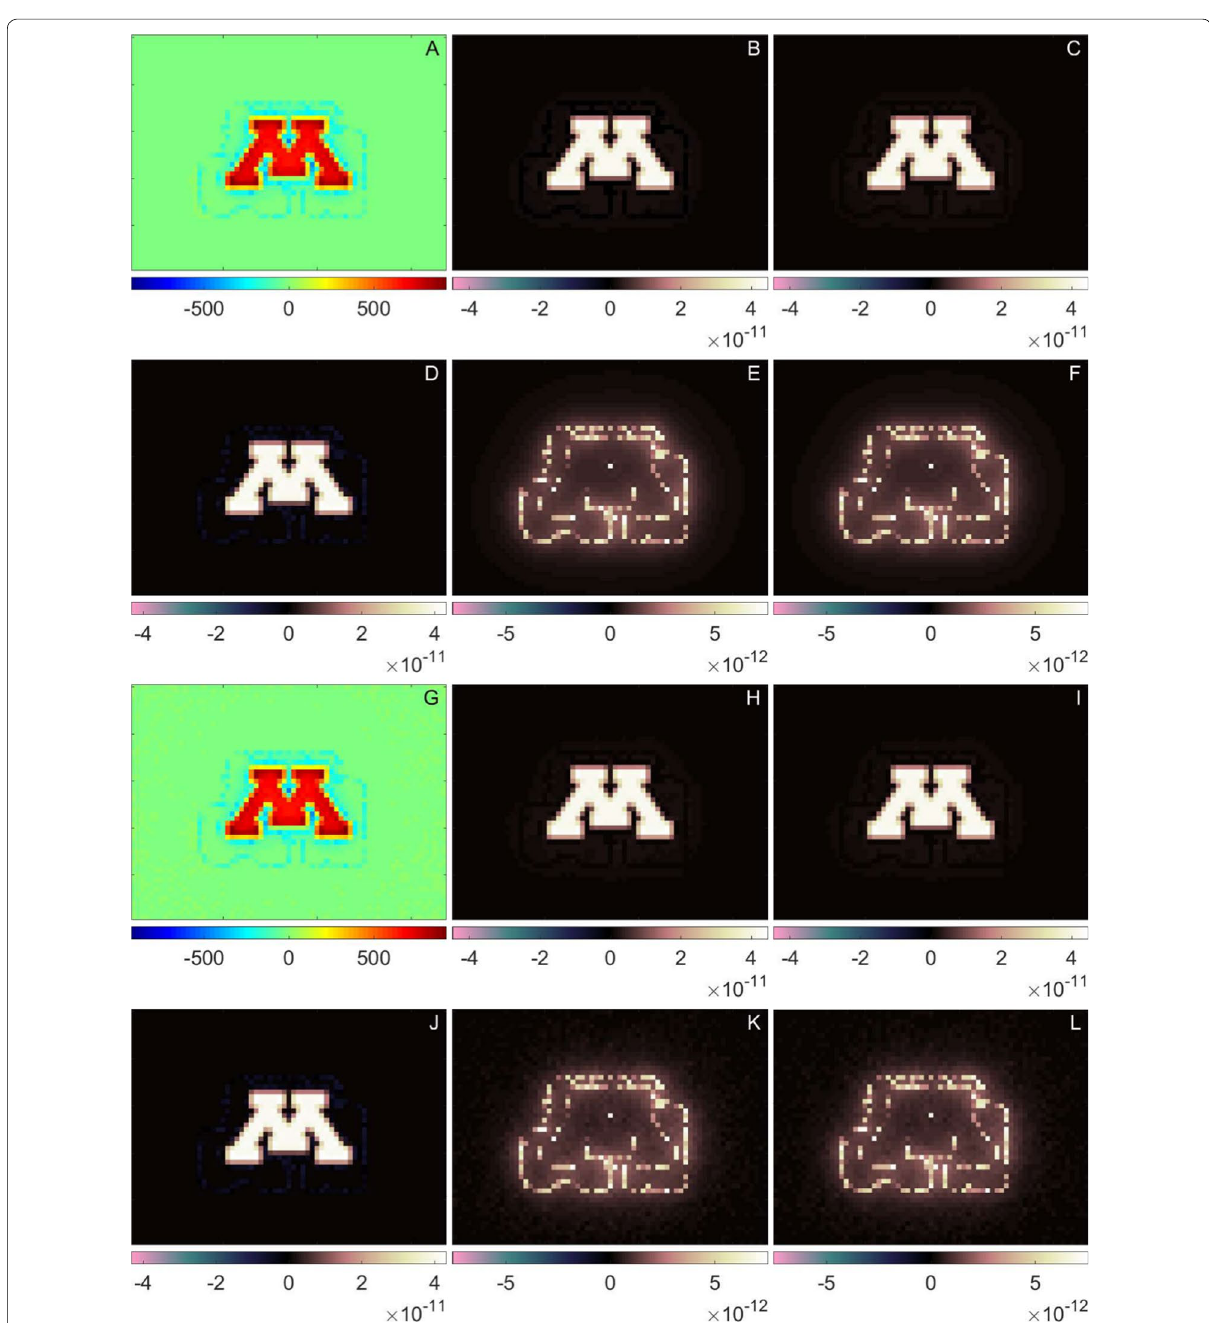
Fig. 4 Comparison of SIRM magnetic sources for synthetic MM data of the UMN logo for scenarios 5 ( a – f ) and 6 ( g – l ): a , g simulated synthetic SIRM B z field in nT calculated from the UMN logo, b , h inverted magnetic sources from the TNT-NN method, c , i inverted magnetic sources from the LH-NNLS method, d , j known magnetic sources used to produce the synthetic MM scan (negative values are difficult to discern as their magnitudes are approximately an order of magnitude less than the positive values), e , k difference between the TNT-NN and known solutions, f , l difference between the LH-NNLS and known solutions. The field of view for each image is 6.7 mm × 5 mm, dipole orientation is out of page, and the units of b – f and h – l are Am